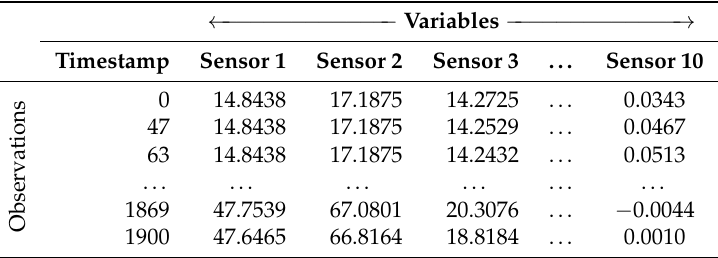
Table 1. Gesture execution example